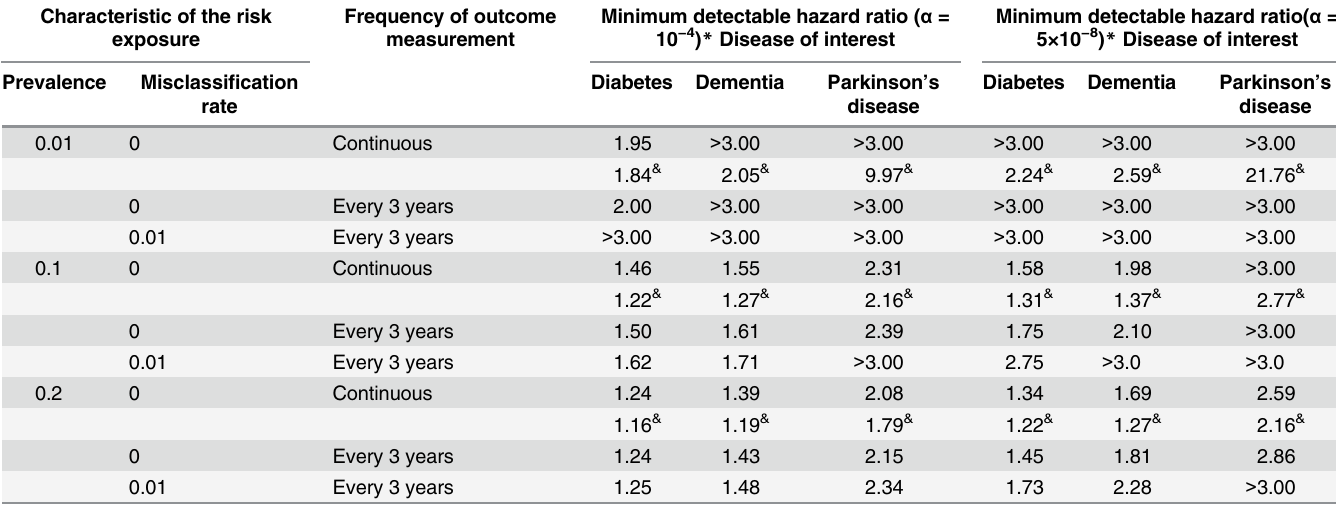
Table 2. Minimum detectable hazard ratio for genetic risk